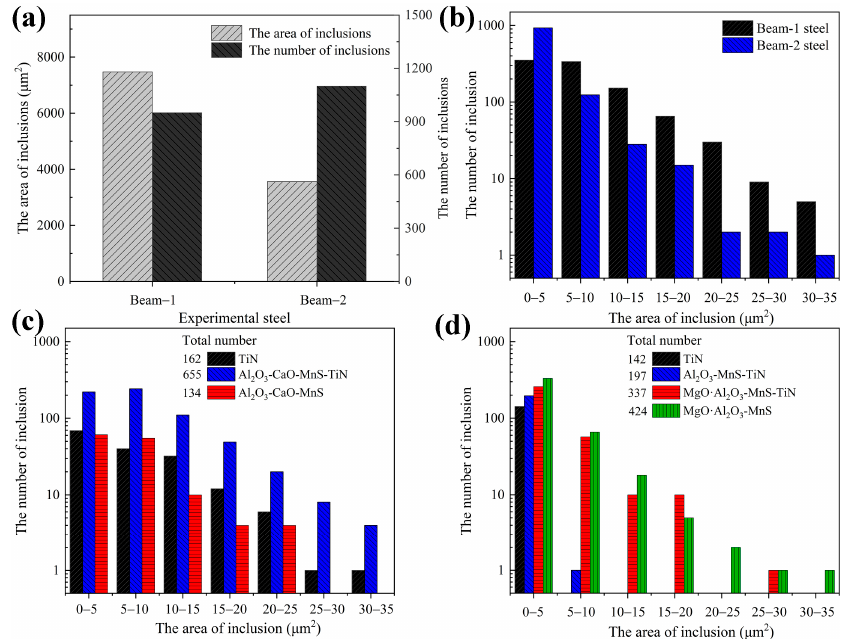
Figure 7. Inclusion number and area distribution in experimental steels: ( a ) total area and number of inclusions, ( b ) inclusion area distribution; ( c ) di ff erent types of inclusions in Beam-1 steel, ( d ) di ff erent types of inclusions in Beam-2 steel.